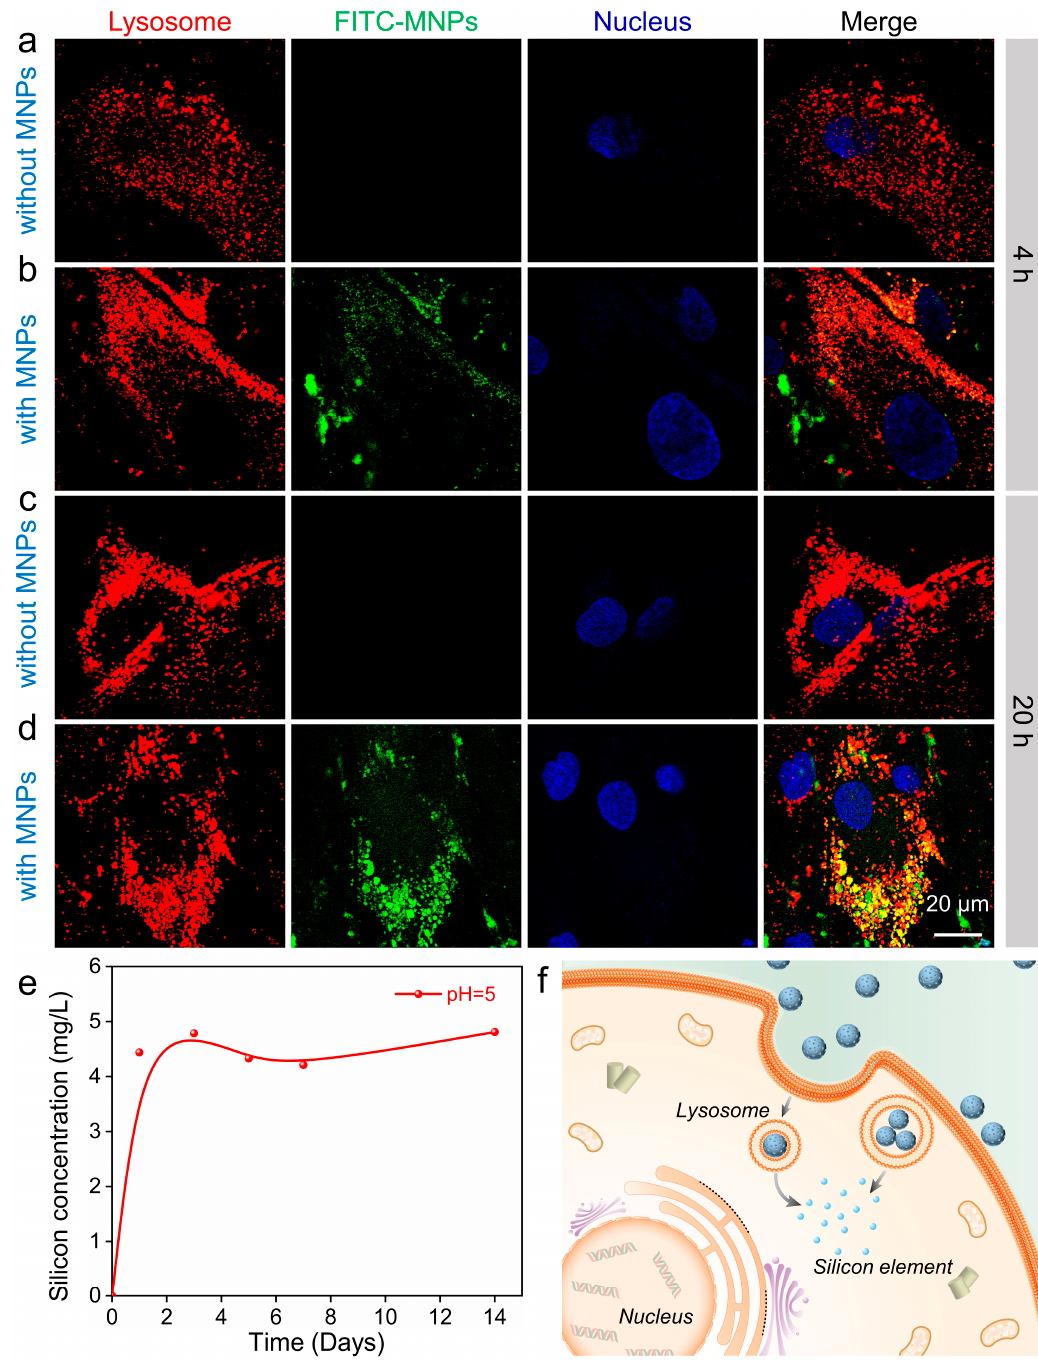
Figure 3. Colocalization between MNPs and lysosomes. Fluorescence images of hADSCs without ( a ) and with MNPs ( b ) for 4 h and cultured without ( c ) and with MNPs ( d ) for 20 h. Lysosomes were stained with LysoTracker (red), MNPs were tagged with FITC (green), and the nucleus was stained with Hoechst (blue). ( e ) Silicon release from MNPs at pH 5 for 14 days. ( f ) Schematic illustration displaying the intracellular processes of MNPs in